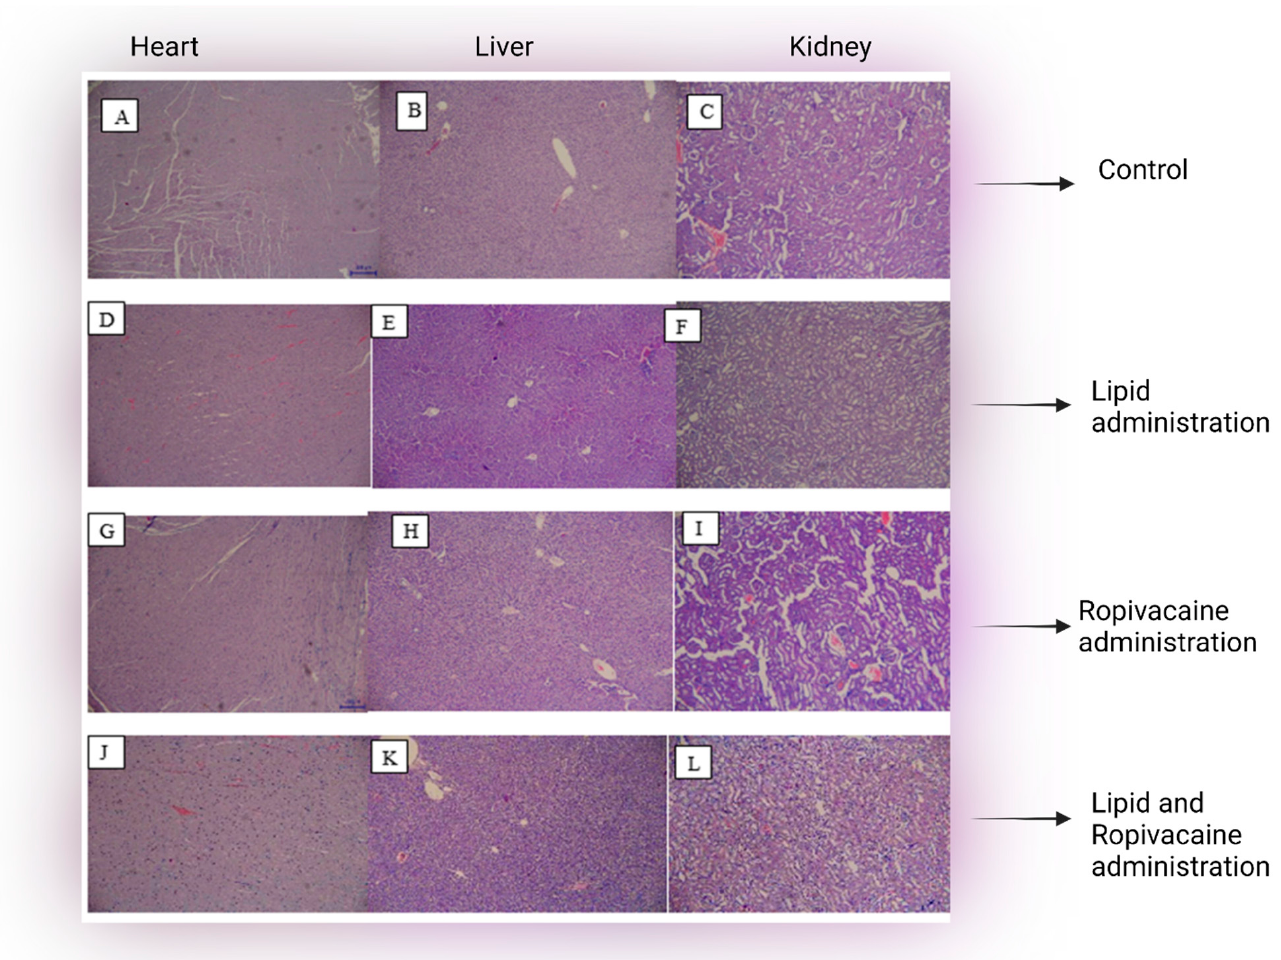
Figure 3. Microscopic assessment of tissue samples from heart, liver and kidney: panels ( A – C )— control; panels ( D – F )—after administration of lipid emulsion only; panels ( G – I )—after local anesthetic (Ropivacaine) administration; panels ( J – L )—after administration of lipid emulsion prior to local anesthetic. No histological changes were seen among groups, in any of the examined organs, after administration of lipid, local anesthetic, or